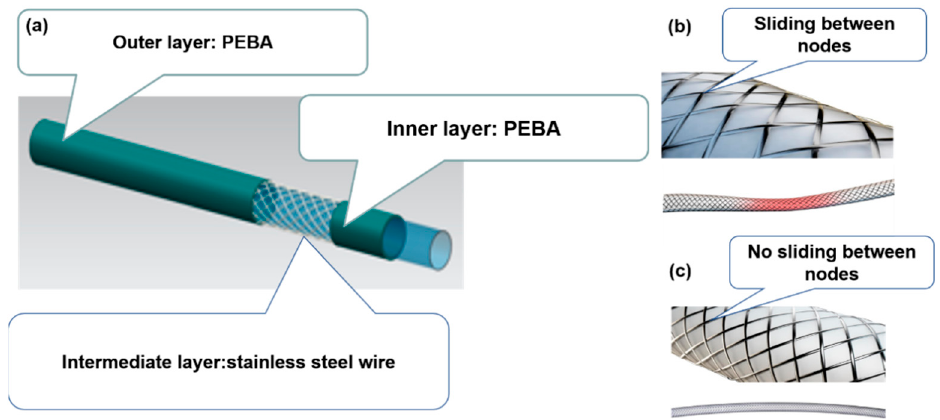
Figure 1. Braided reinforced composite tube. PEBA, polyether block amide, ( a ) composed of inner and outer layers of a base material and an intermediate braided layer, ( b ) sliding between nodes, ( c ) no sliding between nodes.